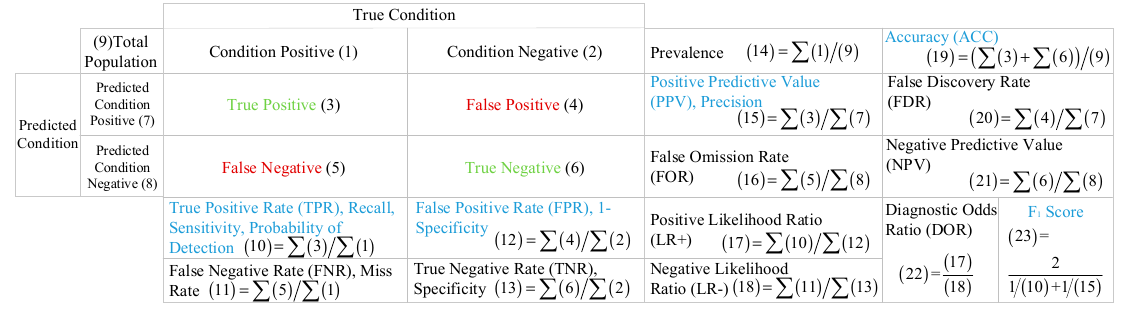
Figure 6. Evolution System of Classification. The four blue ones are our focused indicators.